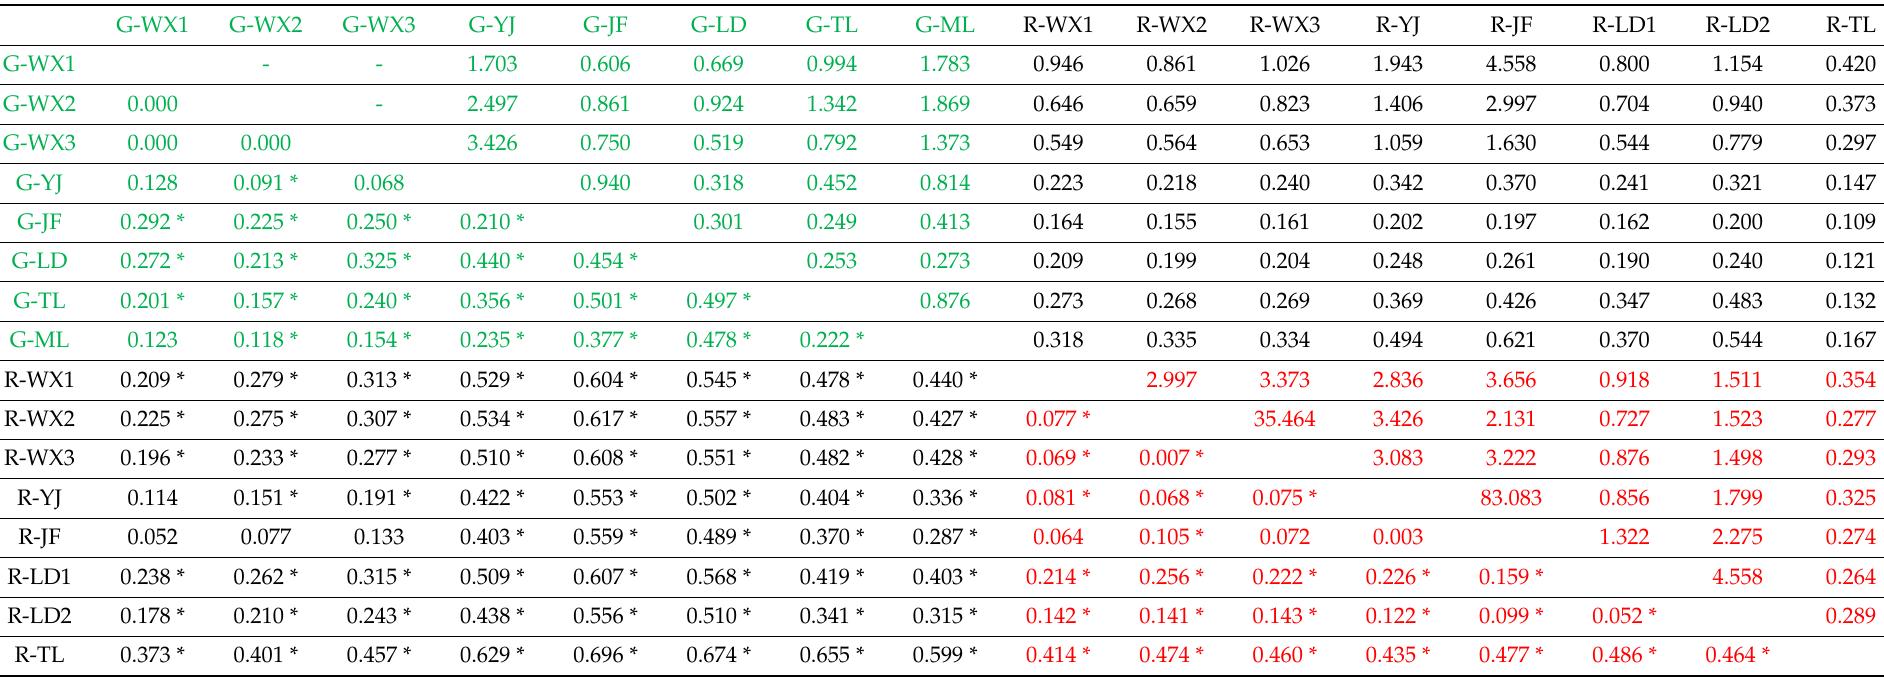
Table 5. Pairwise FST (below diagonal) and gene flow (Nm) (above diagonal) values among 16 populations. Green, red, and black fonts indicate values between populations within green-only, red-only, green and red